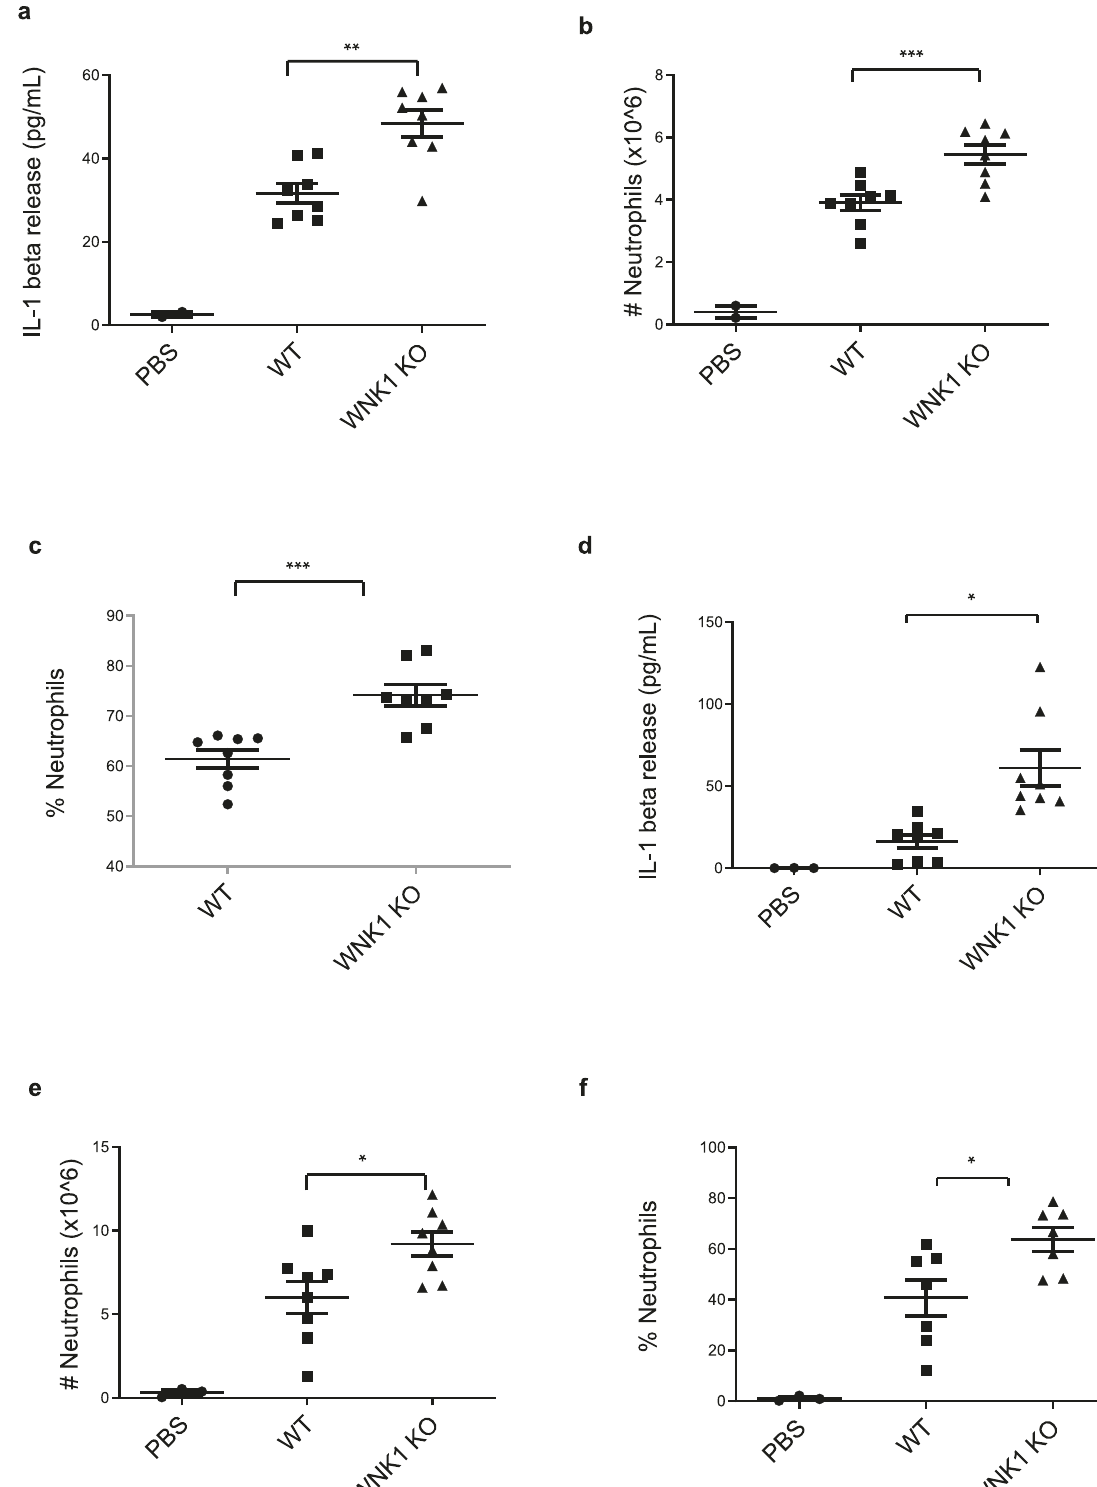
Fig. 8 WNK1 knockout in macrophages increases NLRP3 in fl ammasome activation in vivo. IL-1 β release ( a ), number of in fi ltrating neutrophils ( b ), and percentage of neutrophils ( c ) were measured from peritoneal exudate of Wnk1 + / + LysMCre + (WNK1 WT) and Wnk1 fl ox/ fl ox LysMCre + (WNK1 KO) mice injected with 1 mg MSU for 6 h; n = 8 mice per group. P value for a is 0.002018; b is 0.00009; c is 0.00012. IL-1 β release ( d ), number of in fi ltrating neutrophils ( e ), and percentage of neutrophils ( f ) were measured from peritoneal exudate of Wnk1 + / + LysMCre + (WNK1 WT) and Wnk1 fl ox/ fl ox LysMCre + (WNK1 KO) mice injected with 1 mg MSU for 16 h; n = 8 mice per group. P value for d is 0.01299; e is 0.04810; f is 0.04467. 3 mice per experiment were injected with PBS as a negative control. Error bars in a – f are presented as mean values± standard deviation (S.D.). Two-sided Student ’ s t test, * p < 0.05, ** p < 0.005, *** p <